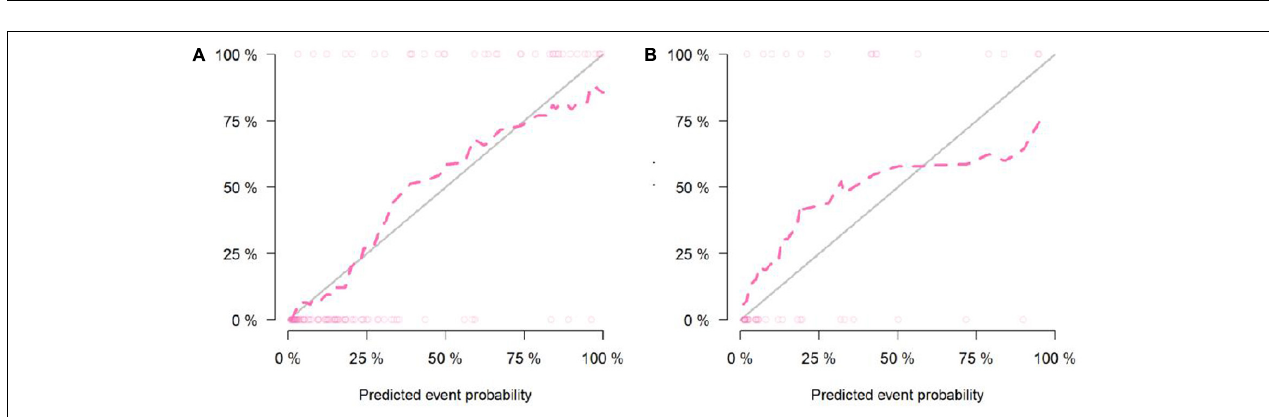
FIGURE 4 | ROC curve for the three model in the training cohort with an AUC of 0.91, 0.83, and 0.85, respectively (A) . ROC curve for the three model in the validation cohort with an AUC of 0.85, 0.83, and 0.77, respectively (B) .